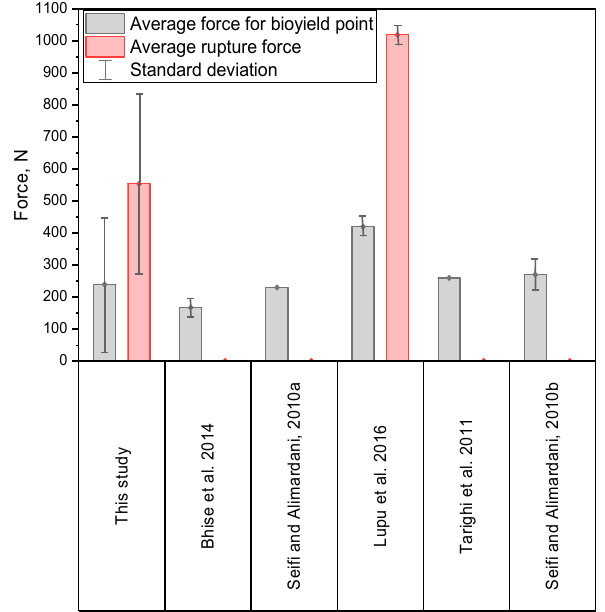
Figure 9. Results of average values of the forces provided in this study compared to the previous study.